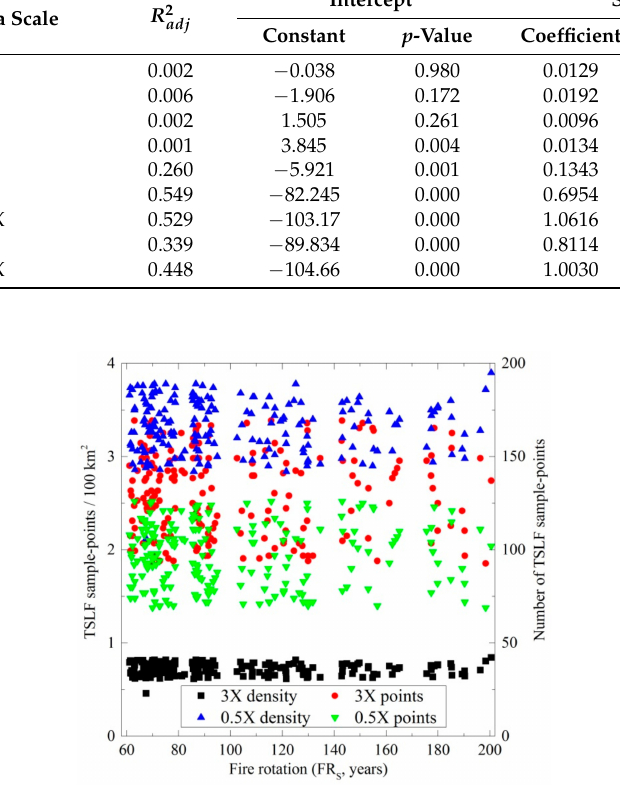
Figure 12. The minimum number of TSLF sample-points to estimate FC MA with an ADMM of 10%. Each sample-point pairs the FR S from the whole 2100 × 2100 grid simulated landscape with the 95th percentile estimate of the 1000 trials of how many TSLF points are required; this was done for all 201 TSLF maps. The minimum number of TSLF sample-points is expressed in two ways: the total number for that study area scale, and the density of sample-points (points/100 km 2 ). Of the nine scales at which these examples were conducted, two are depicted here: 3 × and 0.5 ×